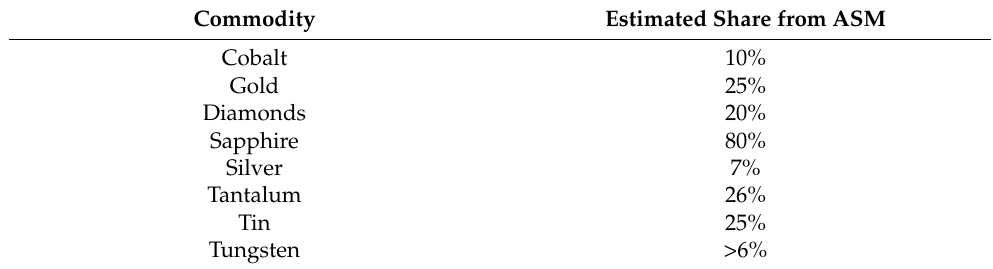
Table 2. Approximate share of world production originating from ASM (sources: [77,79,81,82]). Commodity